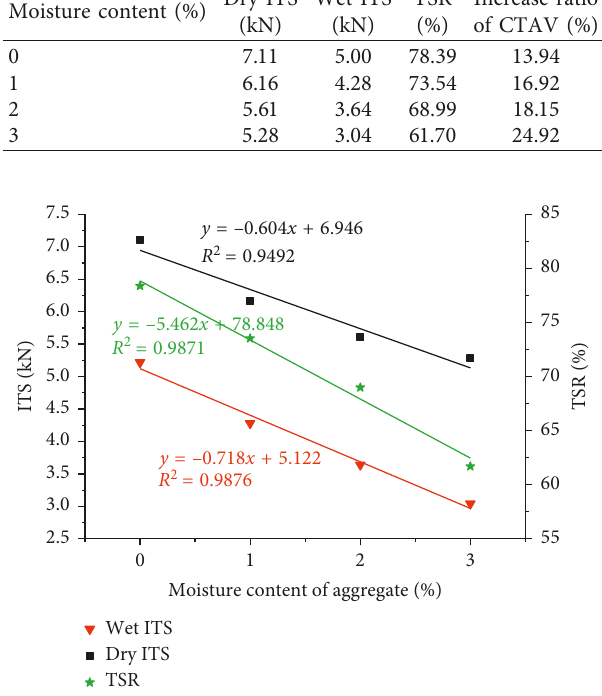
Figure 10: ITS/TSR versus moisture contents of an aggregate of the RH-WMA samples.